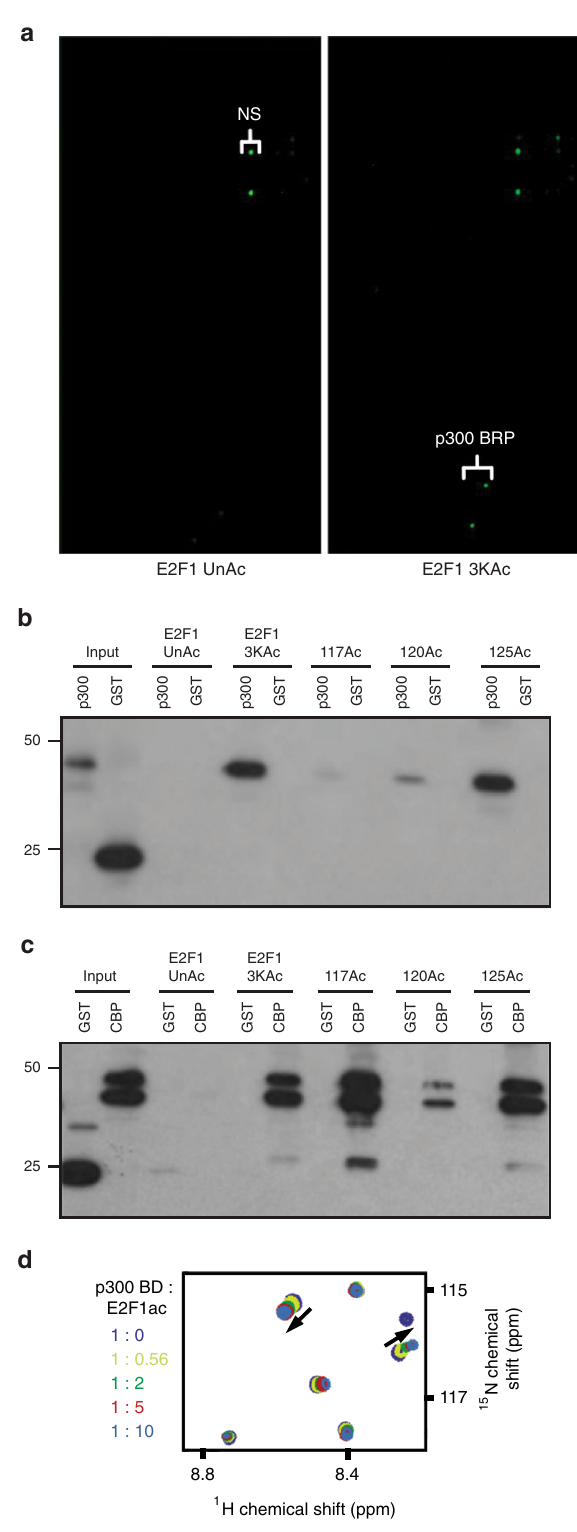
Fig. 1 E2F1 acetylation creates a binding motif for the bromodomains of p300 and CBP. a A tri-acetylated E2F1 peptide (3KAc) but not unacetylated peptide (UnAc) binds to recombinant p300 containing the bromo, ring fi nger, and PHD domains (BRP) in a protein domain microarray. NS indicates nonspeci fi c interaction. b , c E2F1 peptides unacetylated, tri- acetylated, or mono-acetylated at K117, K120, or K125 were incubated with puri fi ed GST-fusion proteins containing the bromodomain domain of p300 ( b ) or CBP ( c ). Following pull-down, western blot for GST was performed to examine binding between p300 or CBP and the E2F1 peptides. d A 1 H, 15 N heteronuclear single quantum coherence NMR titration experiment was performed using the p300 bromodomain and an acetylated E2F1 peptide. Source data of b and c are provided as Supplementary